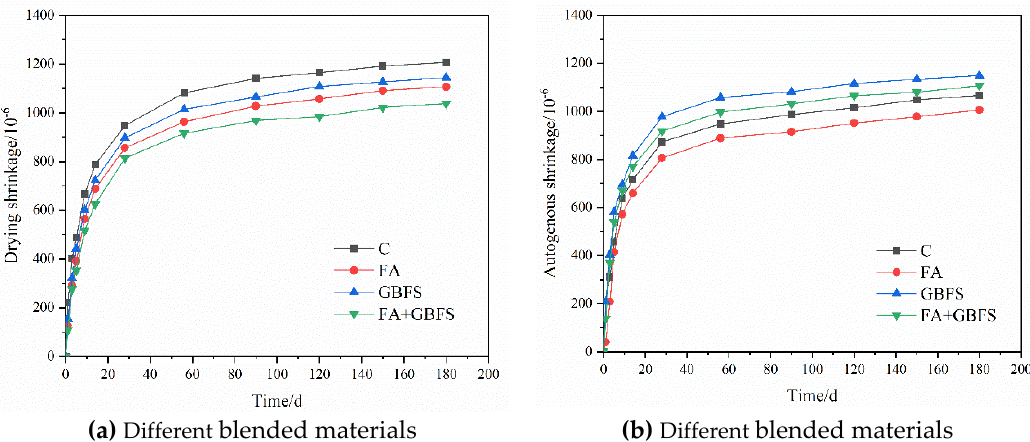
Figure 4. Effect of the blended materials on the shrinkage of mortar: (a ) Drying shrinkage; ( b ) autogenous shrinkage.